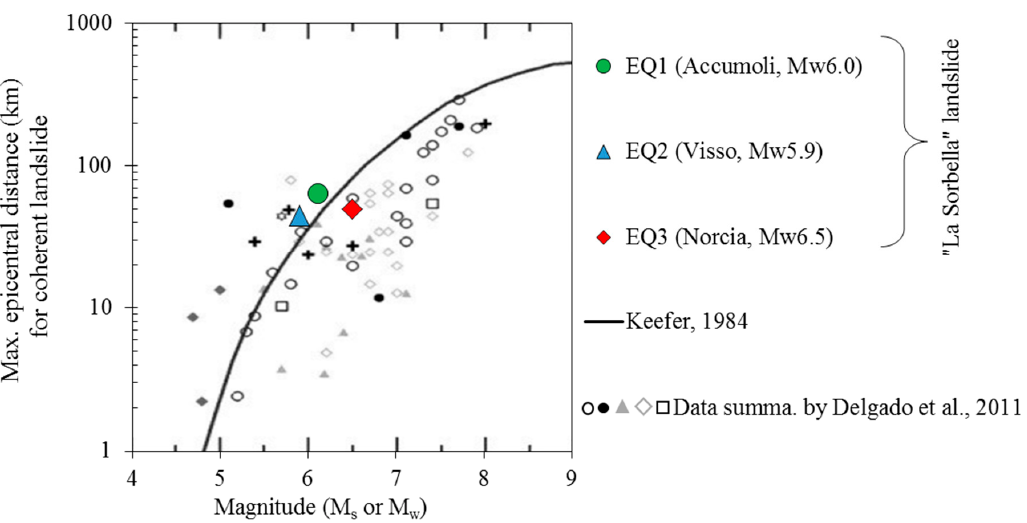
Figure 11. Distribution of maximum distances for seismic-induced landslides as a function of earthquake magnitude: current data versus literature data (modified from Delgado et al, 2011 [16]). Geosciences 2019 , 9 , x FOR PEER REVIEW